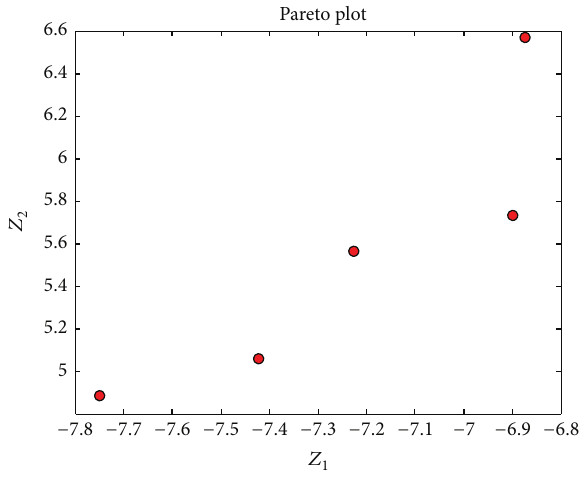
Figure 10: Pareto front of rank and